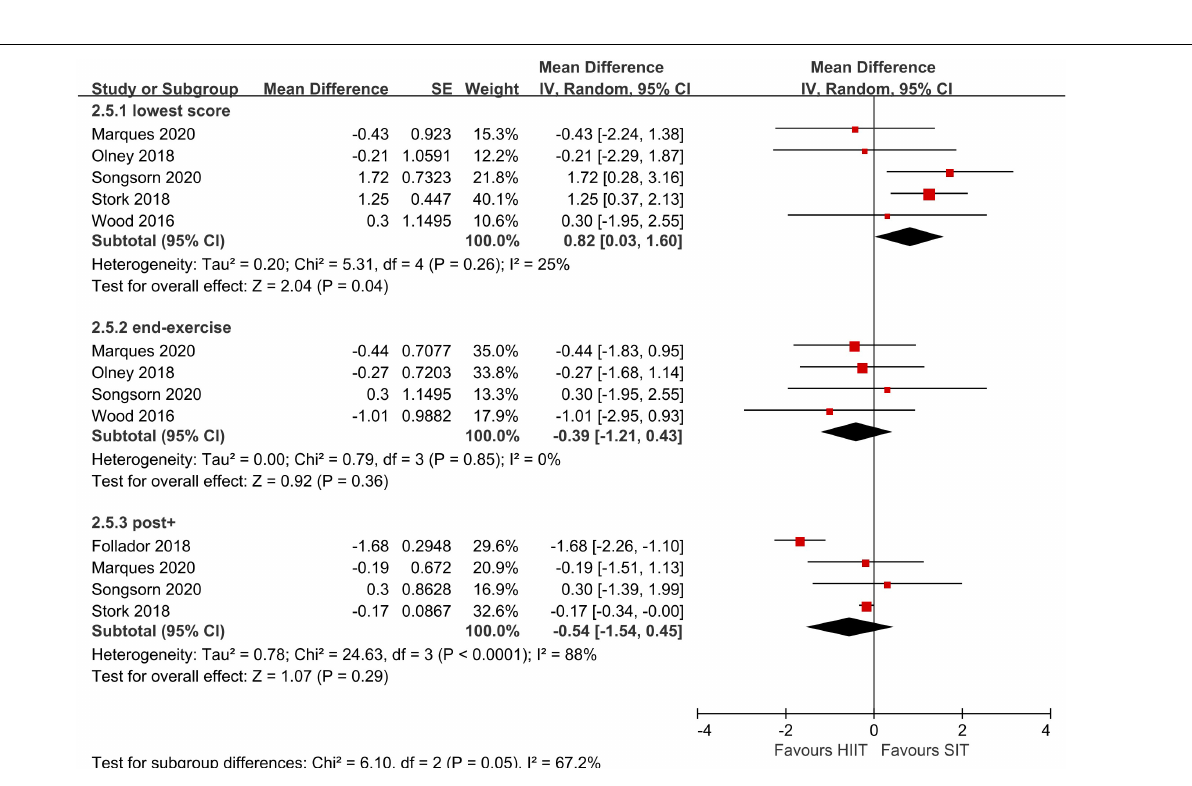
FIGURE 4 | Random effects meta-analyses for the influence of sprint interval training (SIT) vs. high-intensity interval training (HIIT) on affect.